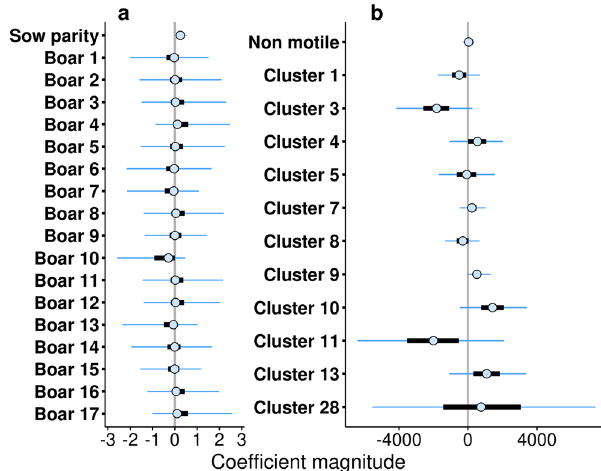
Fig. 2 Estimates of the coef fi cients and their uncertainty in the fertility model. The medians of the coef fi cients are depicted with a clear point, thick black bars represent the 50% credible intervals (C.I.), and the thin lines represent 95% C.I. a Coef fi cients of animal-related factors (sow parity, individual boars). Sow parity corresponds to the number of times that the sow completed a cycle of insemination. The boars (from 1 to 17) are intercepts that vary amongst individuals (usually known as random effect). b Coef fi cients corresponding to sperm behaviour related factors (the proportion of non-motile sperm, and the relative proportions of sperm in each of the motility clusters represented in the landscape). Note the different values in the x-axis (coef fi cient magnitude) for a , b